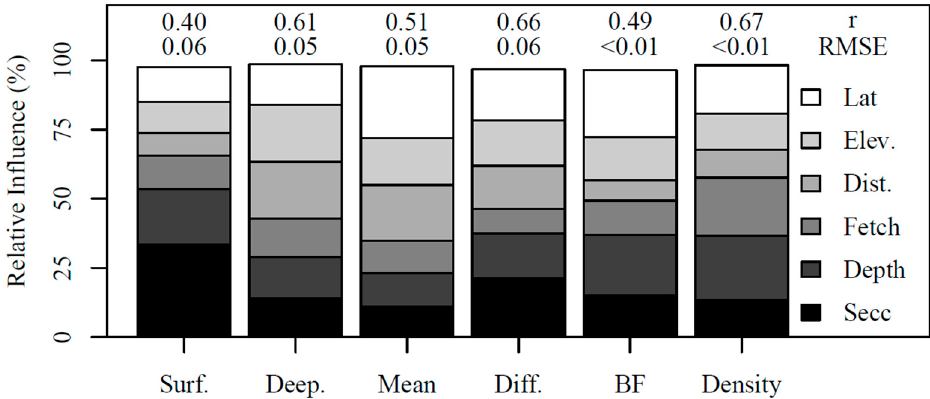
Figure 5. Relative influence of each of the explanatory variables on the trends in slopes of temperature and stratification for NENA lakes from boosted regression tree analysis. For the response slopes: Surf. is the near-surface temperature, Deep. is deepwater temperature, Mean is the depth-weighted mean temperature, Diff. is the temperature difference between near-surface and deepwater, BF is the max. buoyancy frequency and Density is the density gradient. The explanatory variables are indicated by the colors in the legend on the right and are latitude (Lat.), elevation (Elev.), distance to coast (Dist.), fetch (Fetch), depth index (Depth) and Secchi depth (Secc). r and RMSE represent the Pearson correlation coefficients and root mean square error, respectively, between the modeled and actual Sen’s slopes. The bars may not add to 100%; the cohort category accounted for <3% of the relative influence with each response variable.